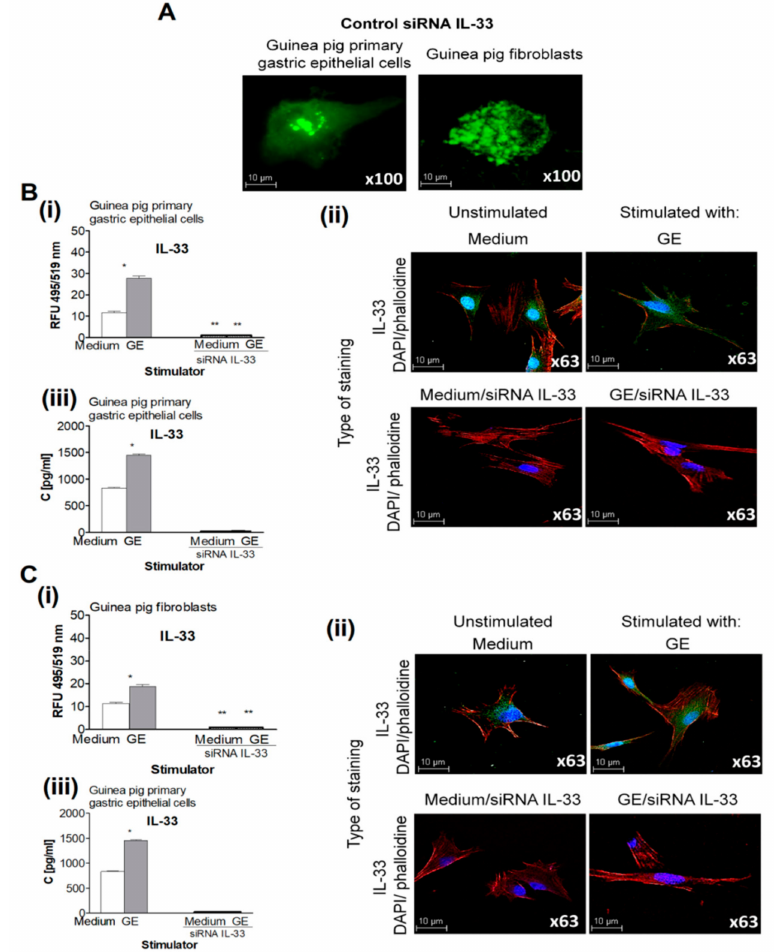
Figure 2. Production of IL-33 in cell cultures exposed to H. pylori components. ( A ) Representative images of guinea pig primary gastric epithelial cells or fibroblasts treated with control siRNA- labelled with fluorescein isothiocyanate; green (FITC) and photographed in the confocal microscope (Leica TCS SP Wetzlar, Germany), at magnification × 100. ( B ) Production of IL-33 by the guinea pig primary gastric epithelial cells not transfected or transfected with siRNA IL-33, unexposed or exposed on H. pylori glycine acid extract